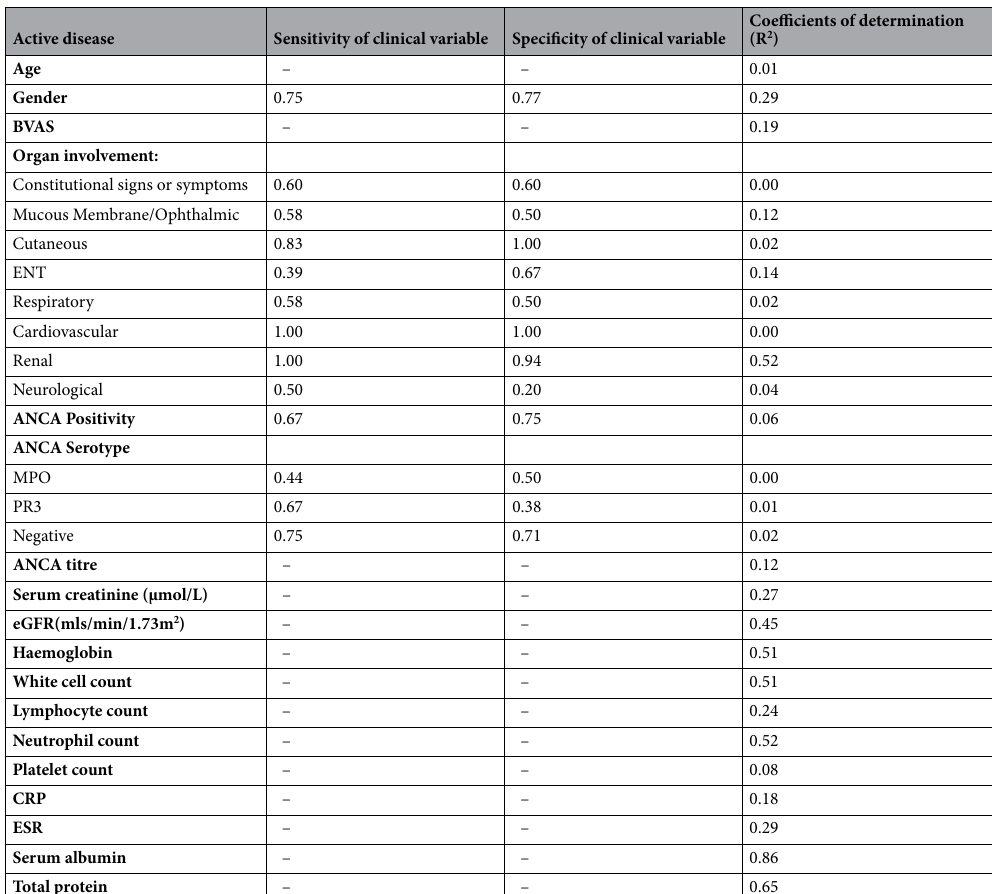
Table 4. Comparative analysis between clinical variables and ATR-FTIR spectral data from plasma samples. ENT ear nose and throat, ANCA anti-neutrophil cytoplasmic autoantibody, MPO myeloperoxidase,